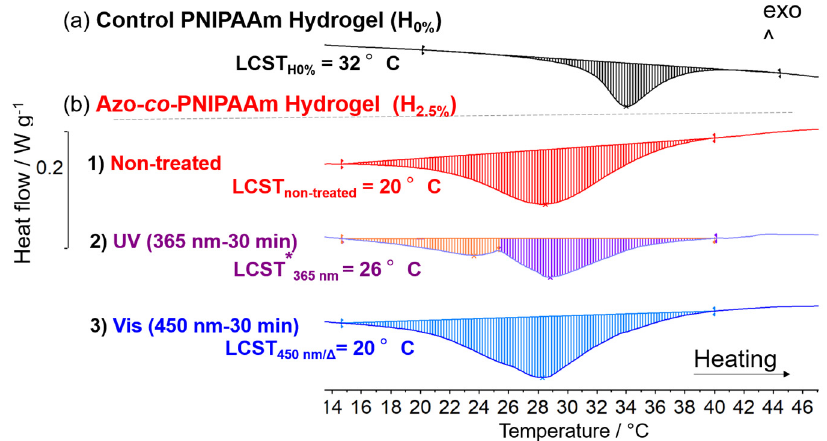
Figure 5. DSC scans (10 K/min) comparing the lower critical solution temperature (LCST) of the Control PNIPAAm ( H 0% ) to the azobenzene (2.5 mol%)-functionalized Azobenzene- co -PNIPAAm hydrogels ( H 2.5% ) hydrogels. ( a ) The onset of the LCST of H 0% in agreement with the literature range between 32 ◦ C for pure PNIPAAm-based systems. ( b1 ) A 12 ◦ C lowering of the LCST in the H 2.5% hydrogel relative to H 0% , indicating the effect of incorporating hydrophobic azobenzene in PNIPAAm; ( b2 ) A bimodal LCST in the photochromic H 2.5% hydrogel with a second endothermic transition temperature, LCST* H2.5%-( Z ) = 26 ◦ C on irradiation UV light ( λ = 365 nm, 30 min); ( b3 ) reversal of the LCST by irradiation with blue light ( λ = 450 nm, 30 min), LCST H2.5%-( E ) = 20 ◦